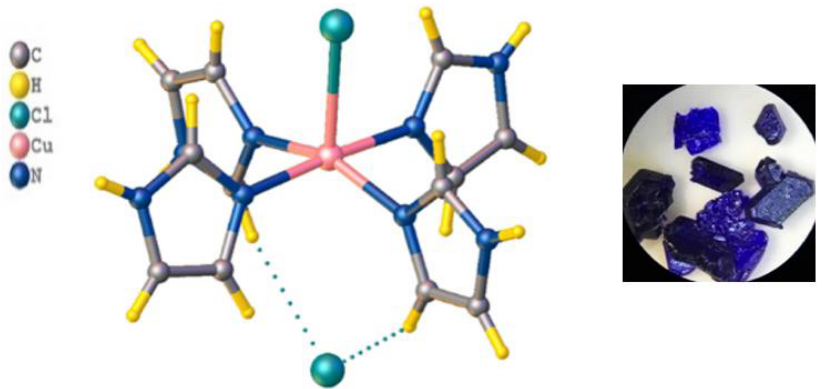
Figure 1. Coordination environment about the Cu(II) metal center of square pyramidal [Cu(II)(C 3 N 2 H 4 ) 4 Cl]Cl coordination complex showing hydrogen bonding as dashed line and its optical image.